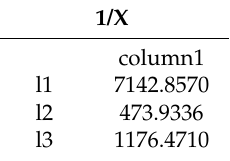
Table A15. Admittance of transmission line between nodes s and m (S): admittance( l ).